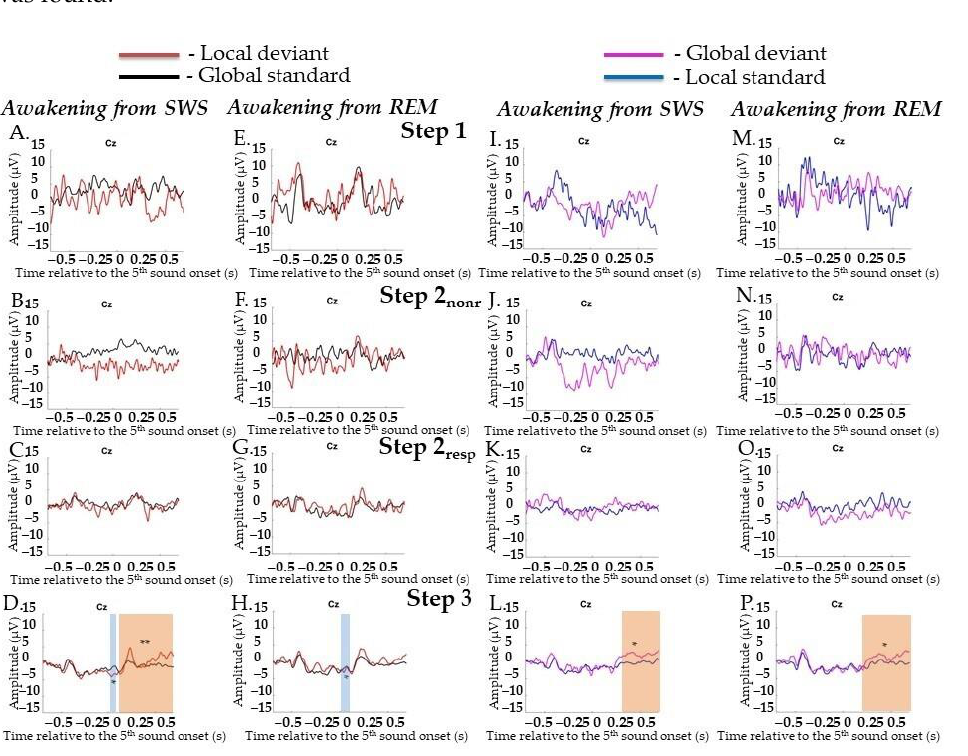
Figure 5. Event-related responses to violation of local regularity and global regularity in the sessions with awakening from slow-wave sleep and rapid eye movement sleep. SWS, slow-wave sleep; REM, rapid eye movement sleep; Step 1, period of awakening when delta or theta prevail in EEG, the motor response is absent; Step 2 nonr , period of awakening when alpha prevails in EEG, the motor response is absent; Step 2 resp , period of awakening when alpha prevails in EEG, the motor response is slow; Step 3, period of awakening when alpha prevails in EEG, the motor response is accurate and timely; s, second; red line, averaged local deviants; black line, averaged global standards; magenta line, averaged global deviants; blue line, averaged local standards. ( A – D ) The session with awakening from SWS for local deviants and global standards. ( E – H ) The session with awakening from REM for local deviants and global standards. ( I – L ) The session with awakening from SWS for global deviants and local standards. ( M – P ) The session with awakening from REM for global deviants and local standards. The blue-shaded region is a pool of negative clusters. The orange-shaded region is a pool of positive clusters. * p < 0.025, ** p <